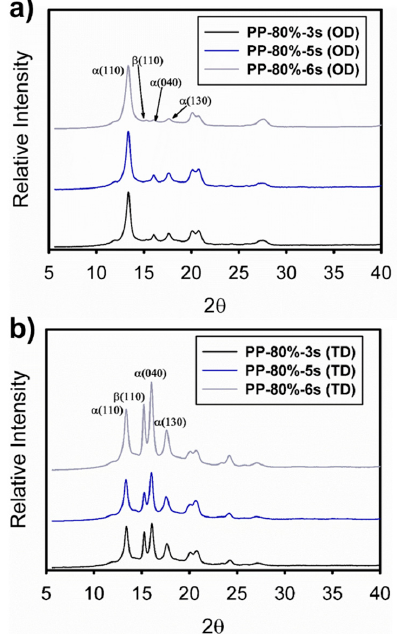
Figure 5. 1D WAXS patterns of the iPP specimens injected at constant amplitude (80%) and different times (3 s, 5 s, and 6 s) taken at different orientation directions: ( a ) orientation direction and ( b ) perpendicular or transverse direction. In addition, the primary crystalline reflections of the α crystalline phase: (110), (040), and (130), and the β crystalline phase (300) of iPP are also shown.